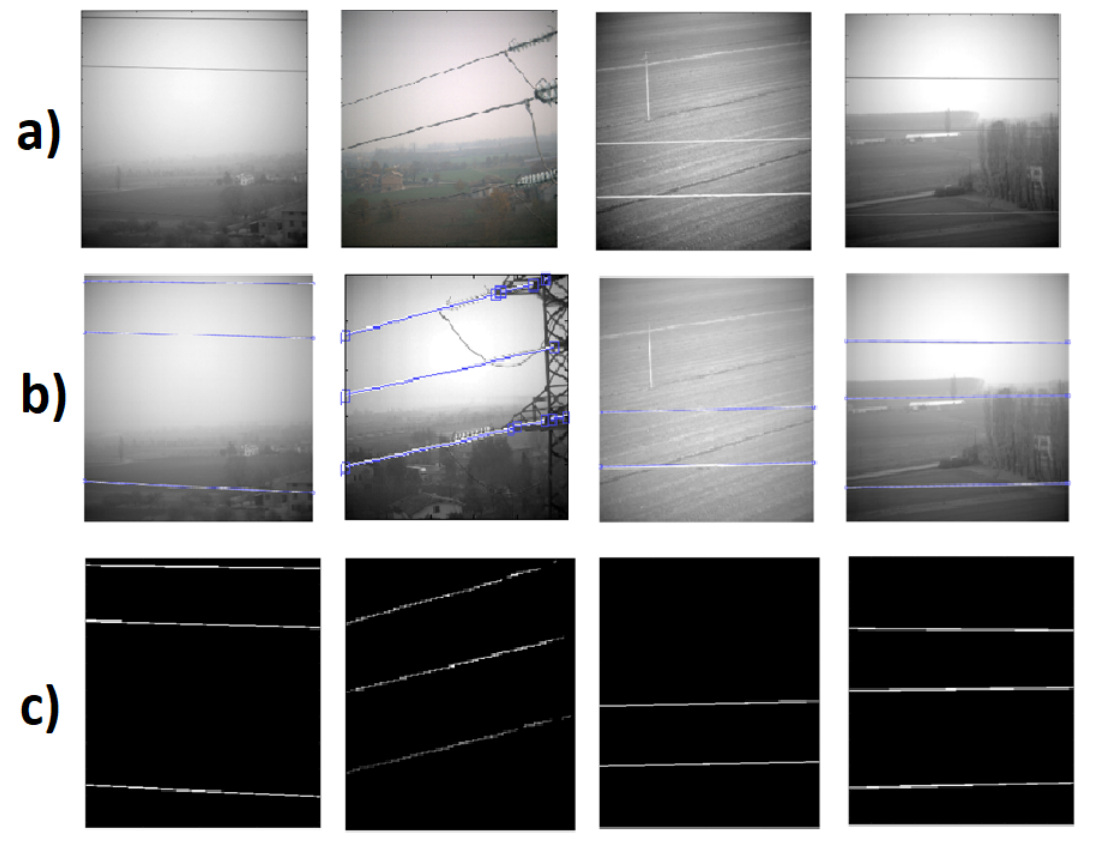
Figure 9. Example of power transmission lines with different backgrounds e.g., cluttered, semi-cluttered and with plain background: ( a ) Power lines on visible image. ( b ) Detected lines using Hough transform. ( c ) Segmented power transmission lines.